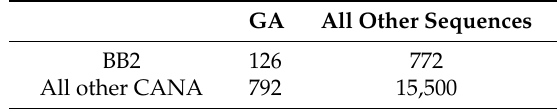
Table 2. The contingency table for the BB2/GA association in the dinucleotide group Regulatory < 6 Å. GA All Other Sequences BB2 126 772 All other CANA 792